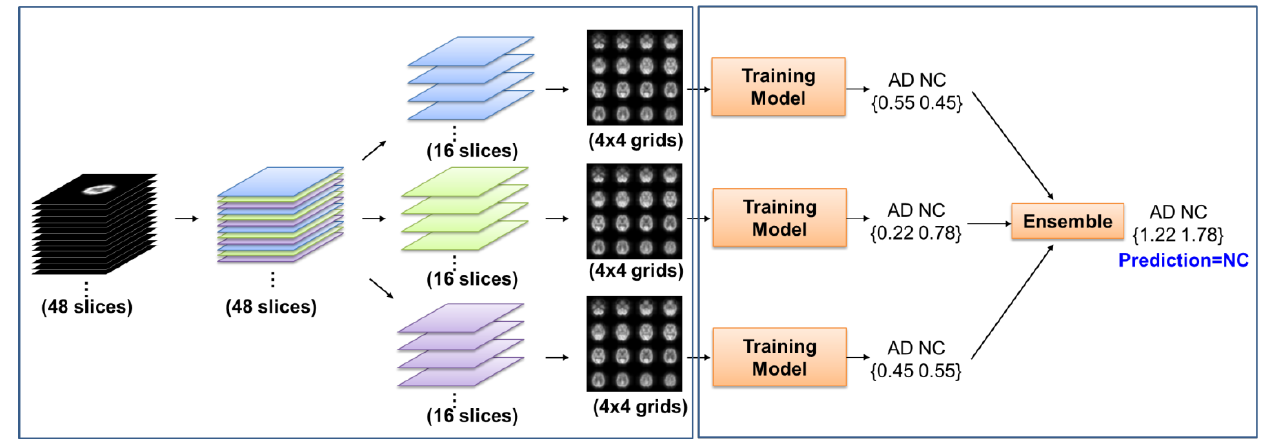
Figure 1. Schematic diagram of the 3D image divided into three 2D images for